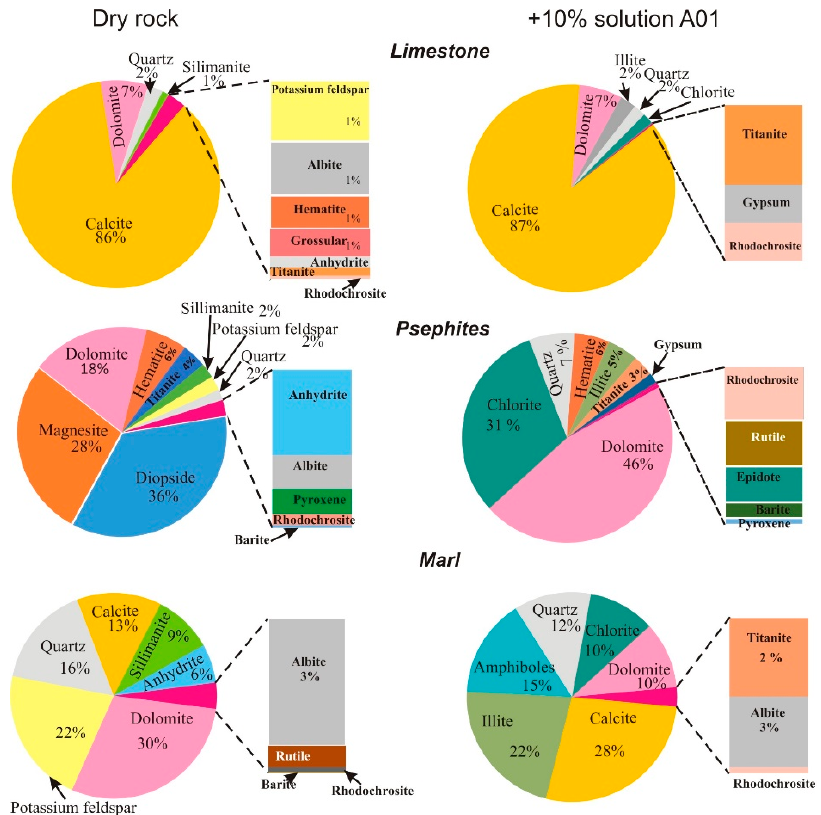
Figure 10. Equilibrium composition of the discussed rocks.